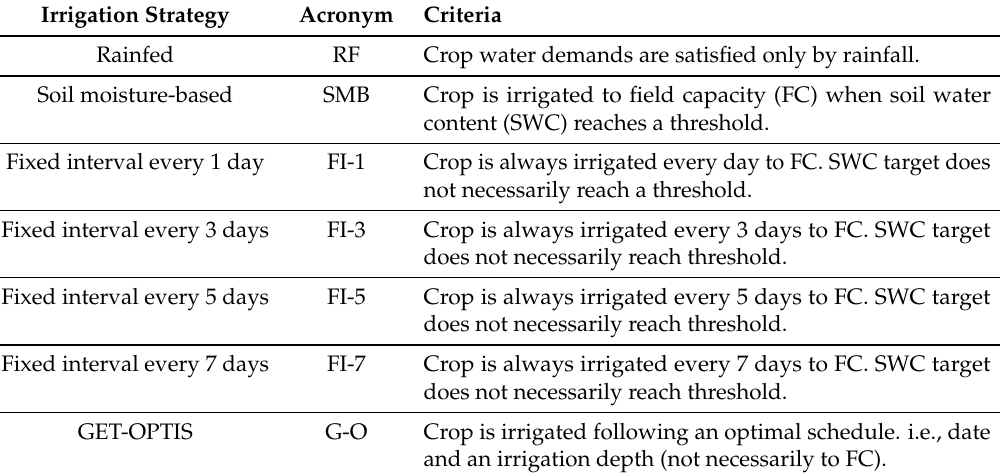
Table 1. Considered irrigation strategies.